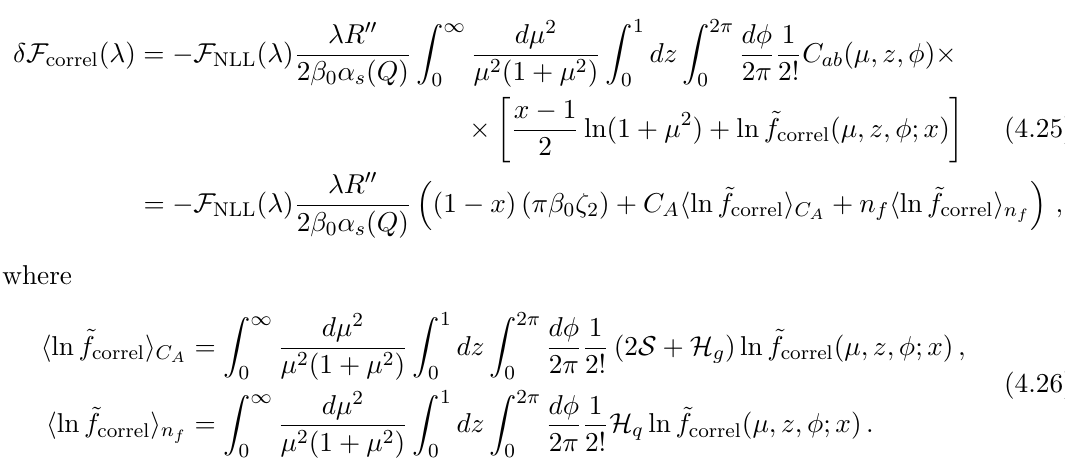
as a function of x f